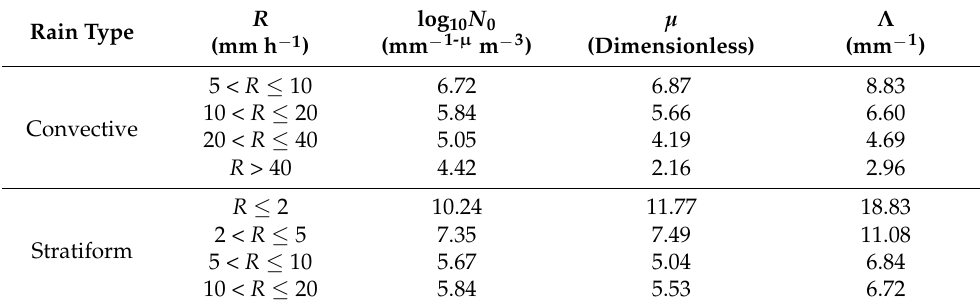
Table 1. Mean values of gamma distribution parameters in terms of different rain